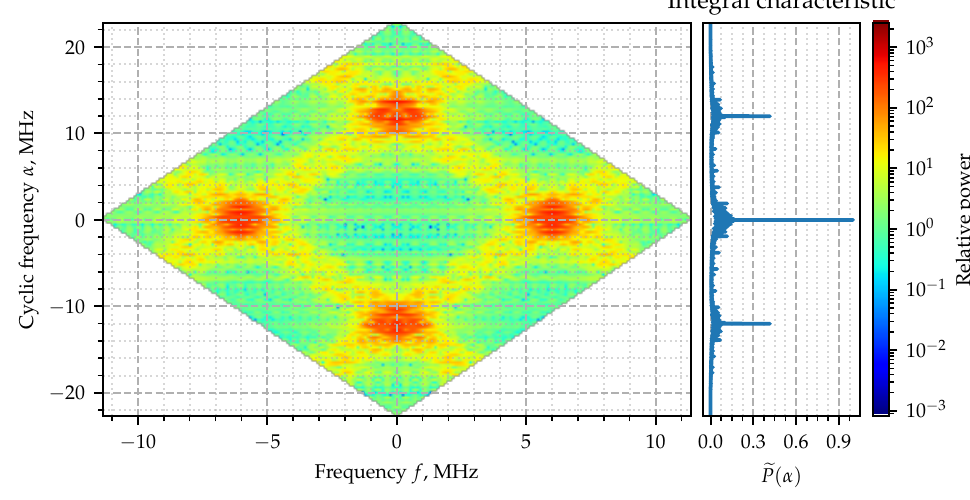
Figure 5. Estimated spectral correlation density of the AM